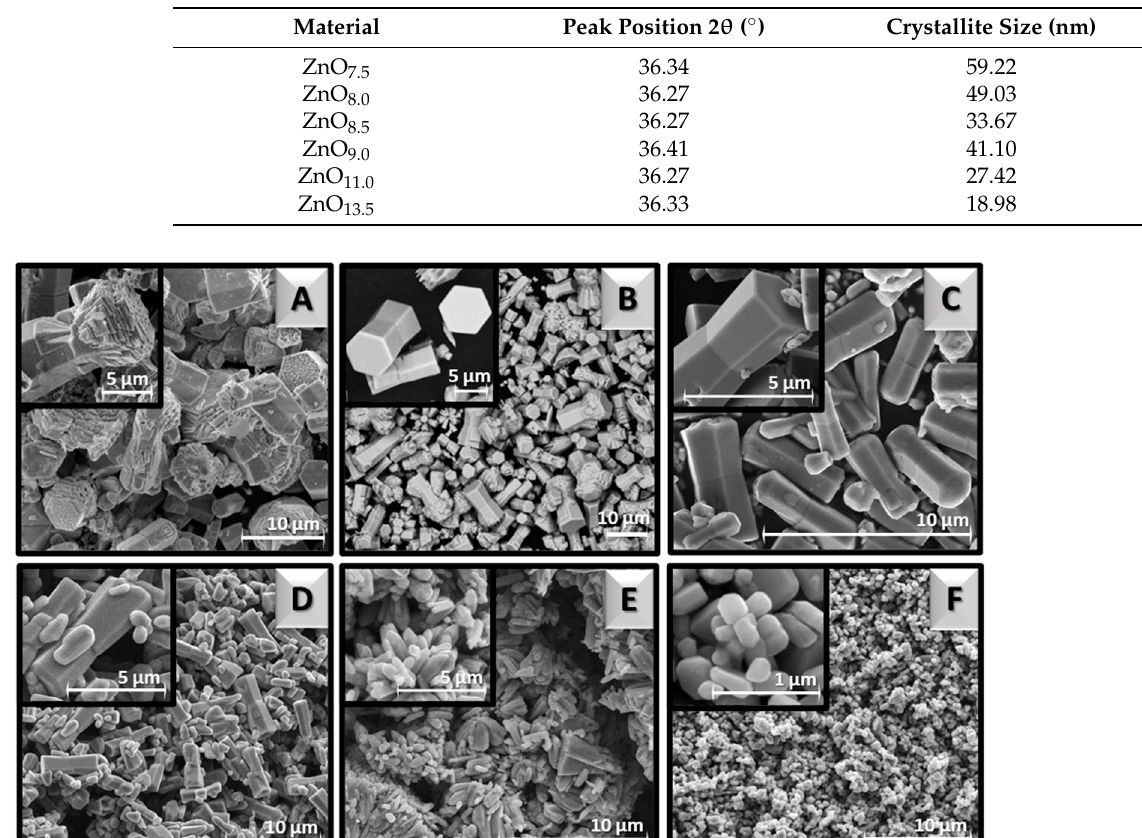
Figure 9. SEM images of ZnO particles synthesized hydrothermally at different pH: 7.5 ( A ), 8.0 ( B ), 8.5 ( C ), 9.0 ( D ), 11.0 ( E ), and 13.5 ( F